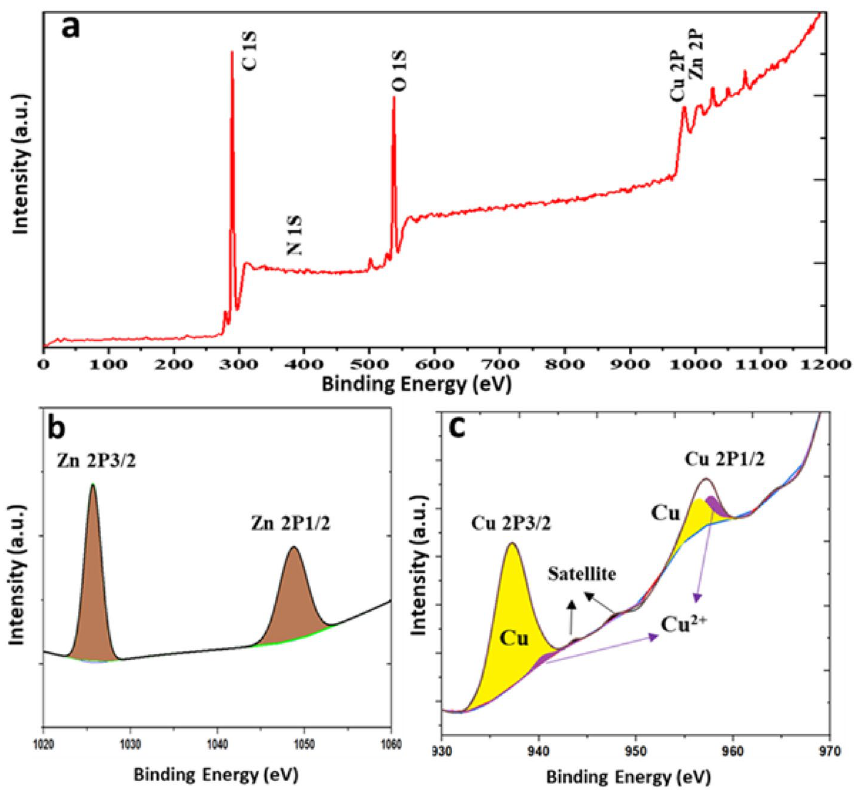
Figure 3. X-ray photoelectron spectroscopy survey analysis ( a ) and the high-resolution spectra of Zn 2p and Cu 2p ( b ), ( c )